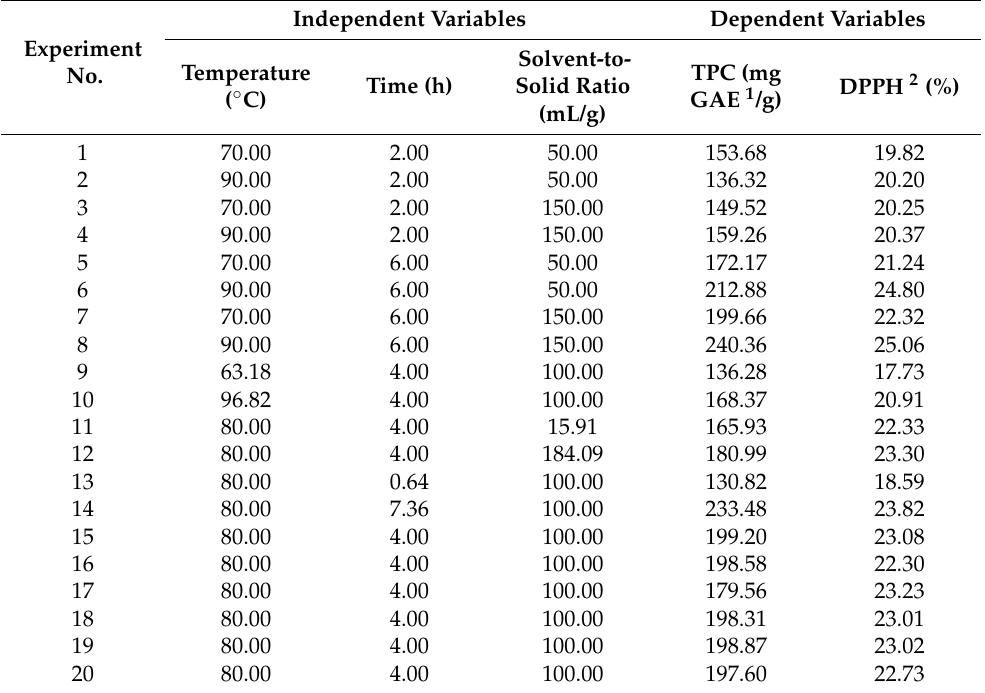
Table 4. The effect of three independent variables for total polyphenol content (TPC) and DPPH activities.